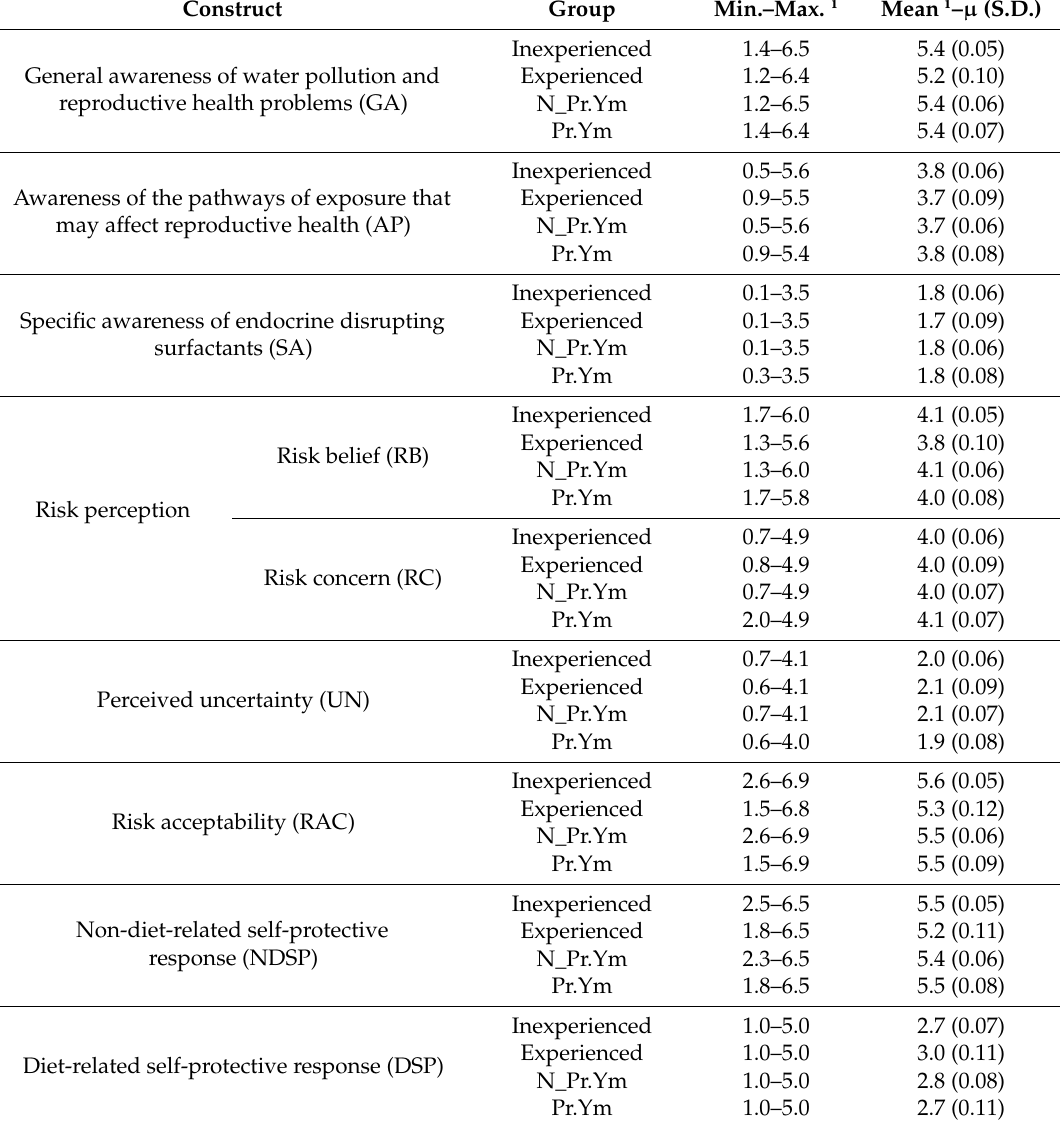
Table 3. Mean values ( n =